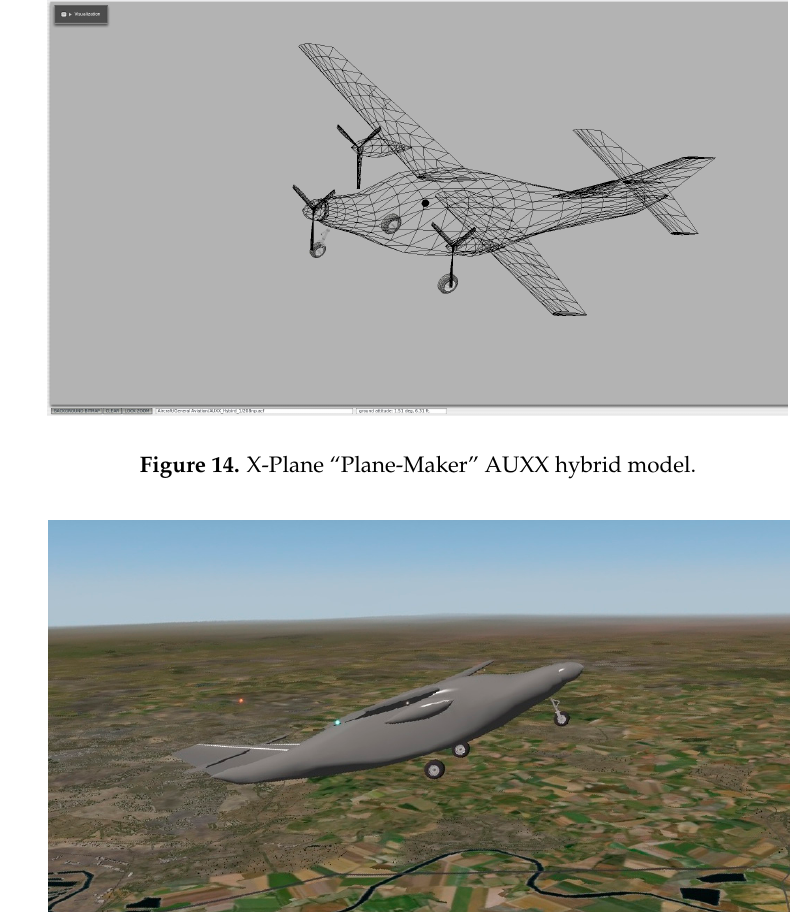
Figure 15. X-Plane AUXX Hybrid unrendered model in simulation flight.